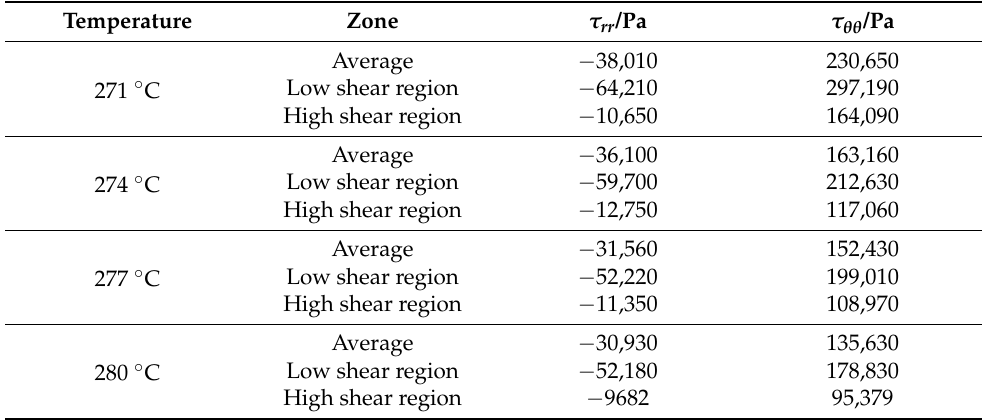
Table 2. The values of 𝝉 𝒓𝒓 and 𝝉 𝜽𝜽 in different temperatures.